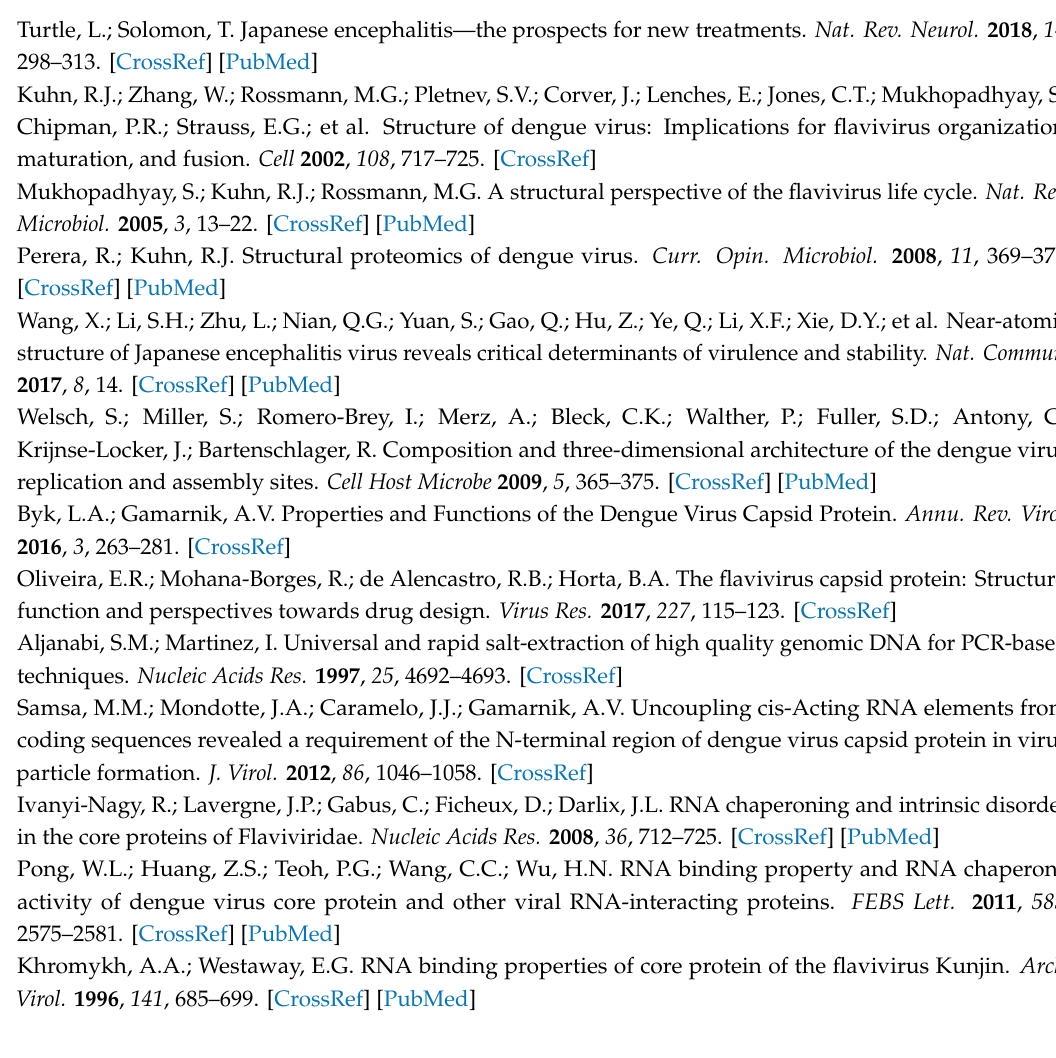
Figure S1: Mass-spectrometry analysis of the JEV capsid protein; Figure S2: Hydrogen bonds at the JEV capsid dimer interface; Figure S3: The DENV capsid α 1- α 3 bundle; Figure S4: The JEV capsid protein lysis bu ff er screening; Table S1: Data collection and refinement statistics; Table S2: Hydrogen bonds between the JEV capsid dimer interfacing residues and the distance; Table S3: Salt bridges between the JEV capsid dimer interfacing residues; Table S4: The JEV capsid dimer interfacing residues reported with accessible surface area (ASA) and buried surface area (BSA), solvation energy e ff ect ( ∆ G) and conservation